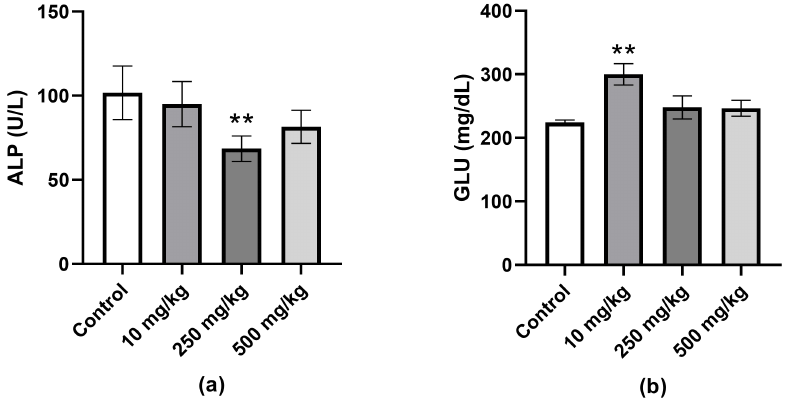
Figure 7. Comparison of the plasma ALP and glucose levels in PsA versus vehicle control-treated Swiss albino mice. ( a ) Plasma ALP levels of female Swiss albino mice treated with PsA. ( b ) Plasma glucose levels of male Swiss albino mice treated with PsA. Data shown as mean ± SEM for n = 5/sex/group. ** indicates a statistical significance at p < 0.01. Table 3. Comparison of PsA versus vehicle control-treated hematological biochemical parameters glucose (GLU), aspartate aminotransferase (AST), alanine aminotransferase (ALT), alkaline phosphatase (ALP), blood urea nitrogen (BUN), and creatinine (CREAT) in male Swiss albino mice. Data shown as mean ± SEM for n = 5/sex/group.